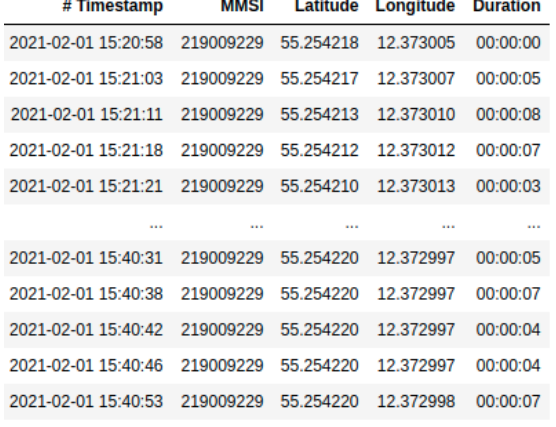
Figure 3 . Example of AIS data (220 messages) for a particular vessel